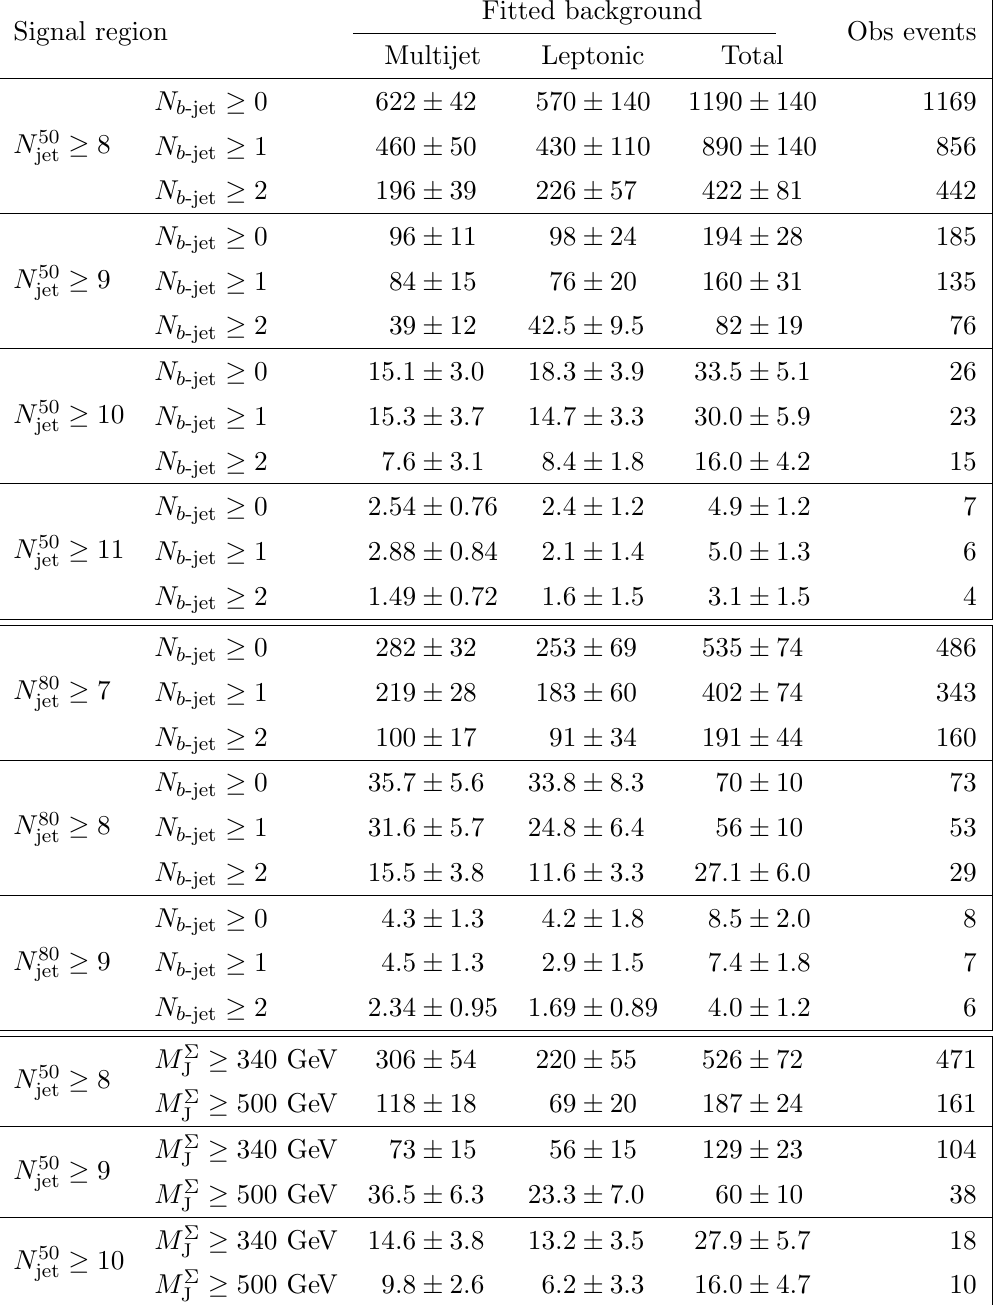
Table 4. The expected SM background (and separately the multijet and leptonic contributions) and the observed number of data events. The SM background normalisations are obtained from (cid:12)ts to the data in control regions, as described in the